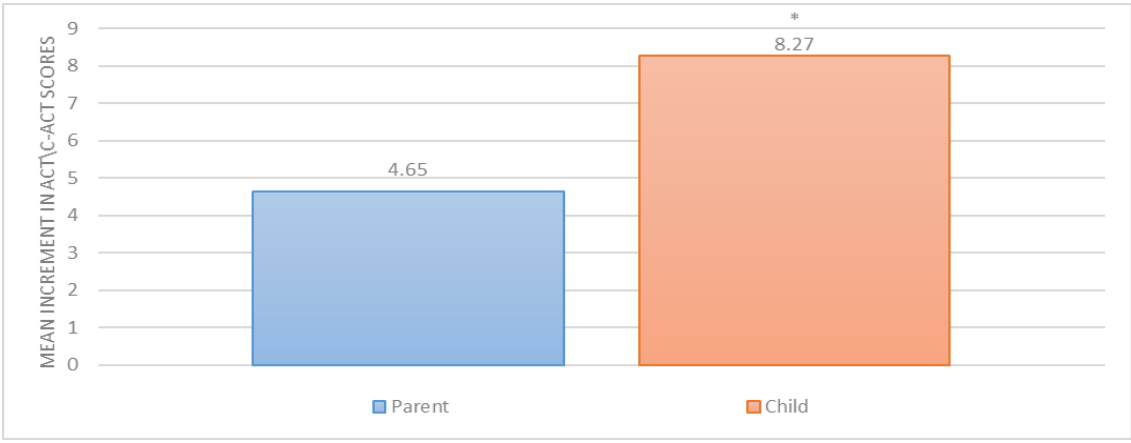
ؤة Figure 5. Mean increment in ACT\C-ACT scores after pharmacist intervention according to